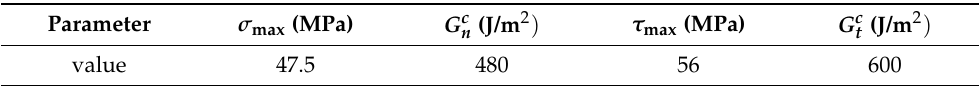
Table 5. CZM parameters for SAC305 [27].